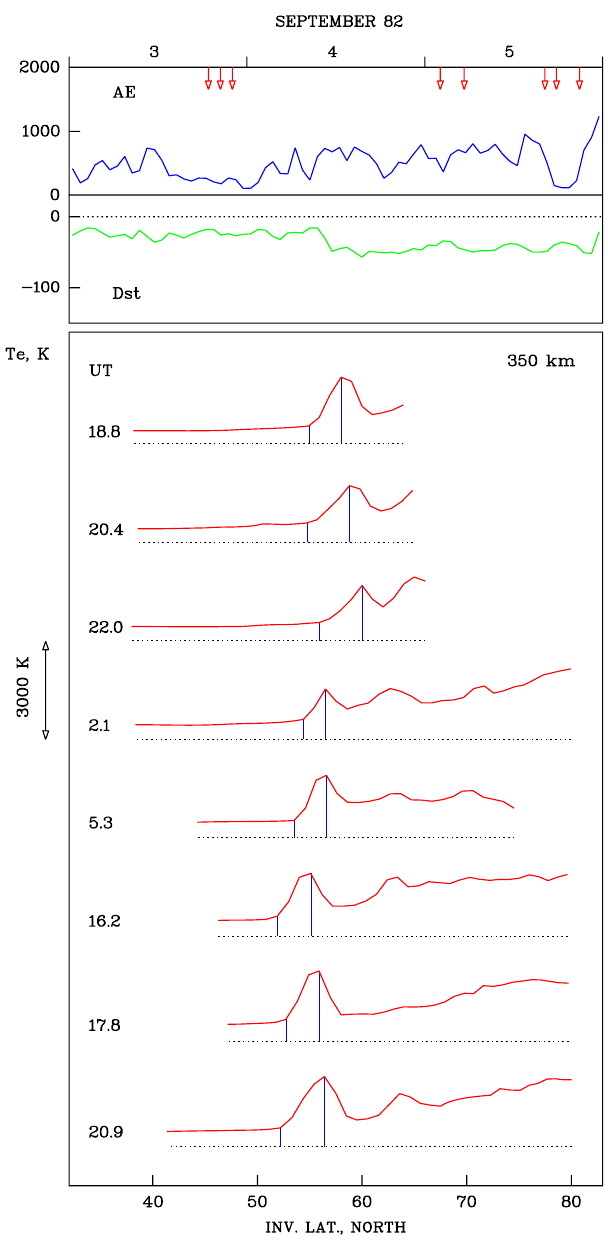
Fig. 2. Latitudinal variation of the electron temperature in the subauroral region during magnetically active conditions. In the upper part of the figure, the AE and Dst indices are used to describe geomagnetic activity during three days in September 1982. During this time, eight latitudinal profiles of the electron temperature were obtained by the DE–2 satellite. They are shown in the form of a stack plot in the lower part of the figure. The times of observation are indicated next to each profile, and also by arrows in the upper part of the figure. Dotted reference lines mark the 600K temperature level. The common temperature scale is indicated by an arrow on the left-hand side. Using a constant temperature gradient of 1K/km, all temperature measurements have been adjusted to a common altitude of 350km. This reference altitude lies within the range of the actual observation heights. Solar local time of observation is approximately 24h, and the magnetic local time varies between 23 and 1h. For each profile, vertical blue lines mark the latitudes of the equatorward boundary (= latb ) and the first maximum (= latm ) of the electron temperature enhancement. The associated temperatures are denoted as T e(latb) = T eb and T e(latm) = T em ,